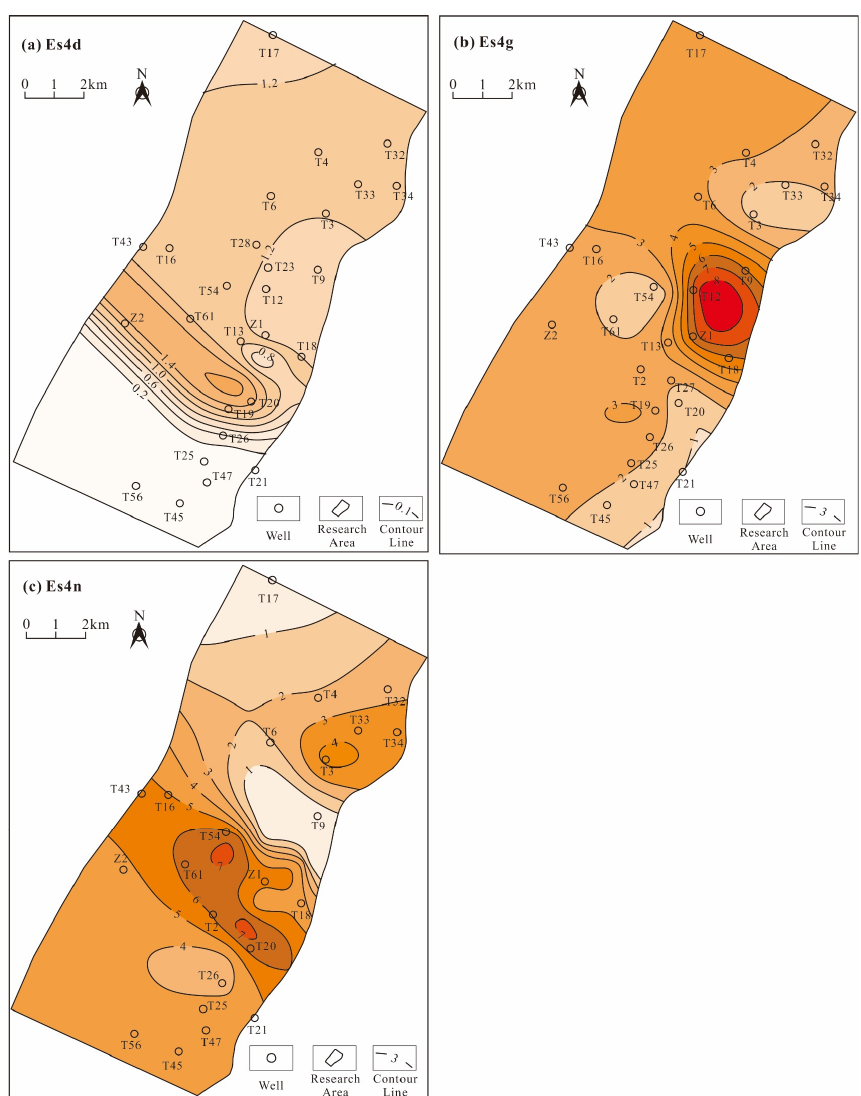
Figure 15. Distribution of the restored TOCo of the Es4 source rocks in the Niuxintuo area. ( a ) The ES4d source rocks; ( b ) The ES4g source rocks; ( c ) The ES4n source rocks.